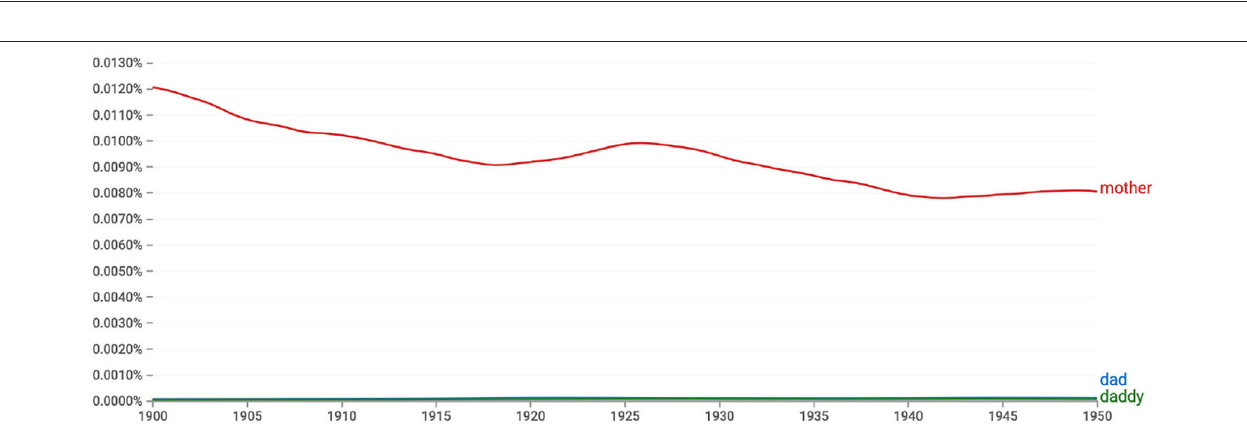
binomials and the ordering of novel binomials is: cognitive accessibility. We review three relevant aspects of accessibility immediately